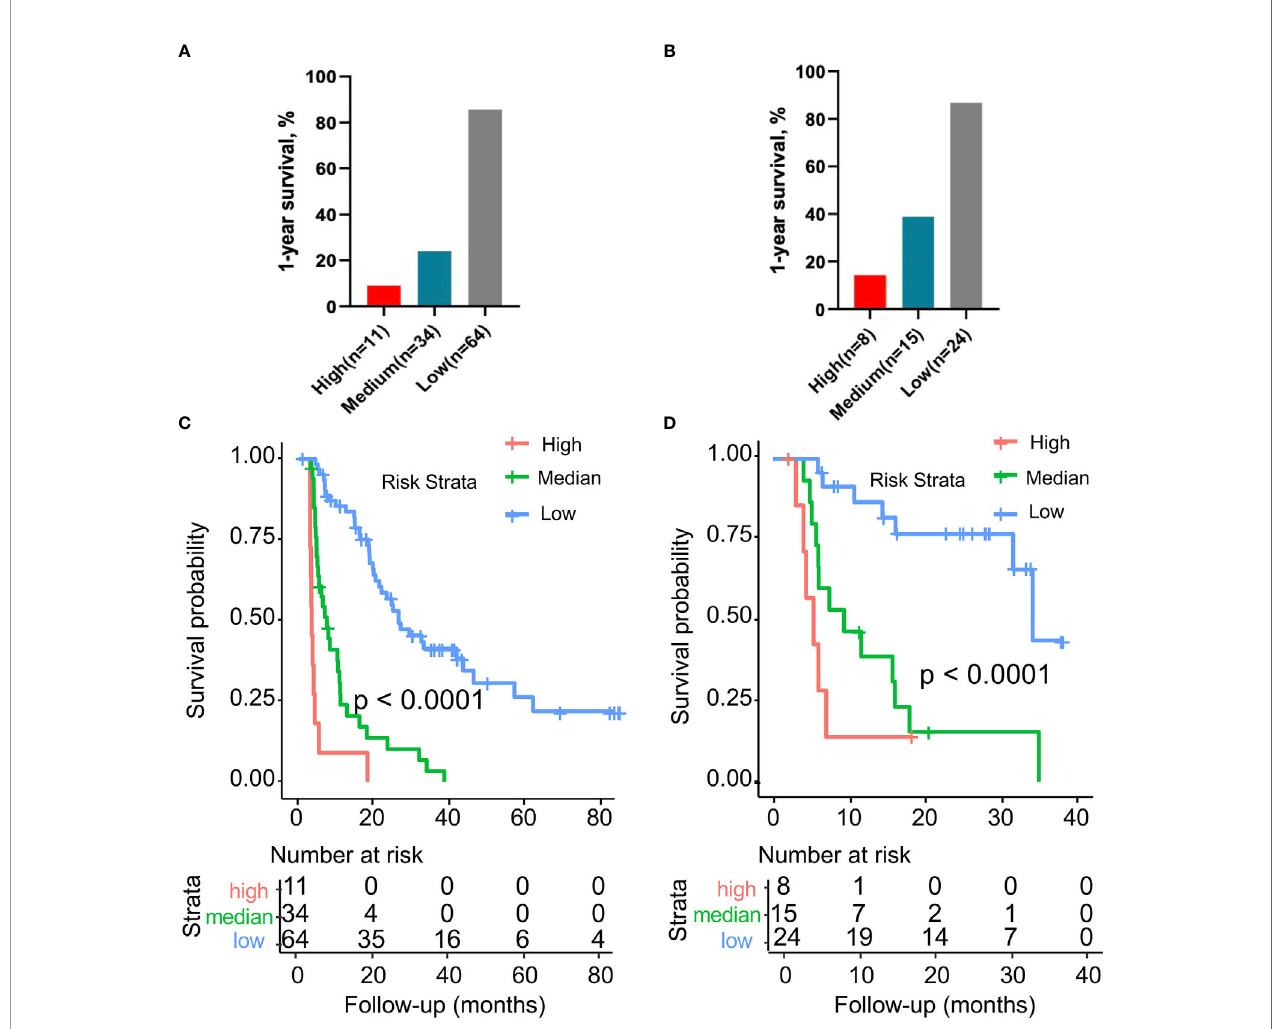
FIGURE 4 | (A) Comparison of the 1-year recurrence-free survival rate in the training cohort with different risk strati fi cations. (B) Comparison of the 1-year recurrence-free survival rate in the validation cohort with different risk strati fi cations. (C) Kaplan – Meier survival curves for the three risk strati fi cation groups in the training cohort. (D) Kaplan – Meier survival curves for the three risk strati fi cation groups in the validation cohort. Risk strati fi cation system: low risk, 0 to 16 points; medium risk, 17 to 29 points; high risk, 30 to 40